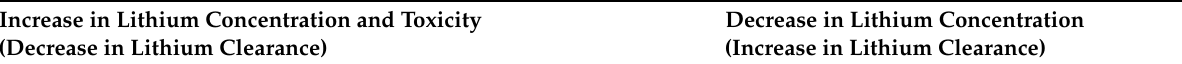
Table 1. Pharmacokinetic interactions between lithium and other drugs (the effect via renal lithium